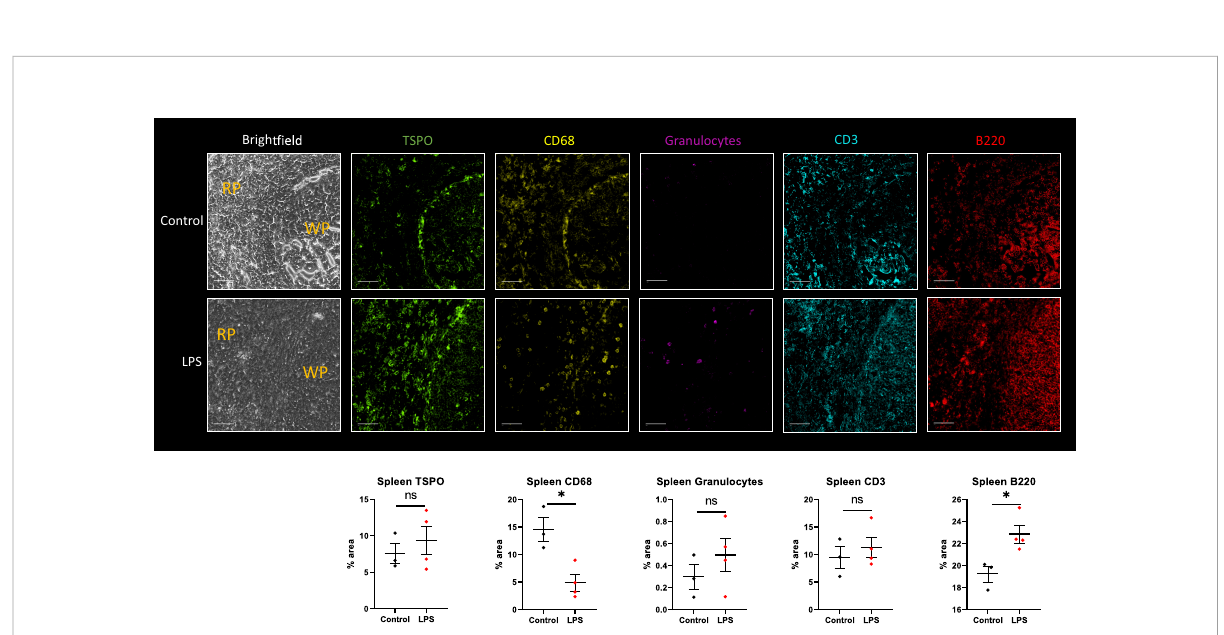
FIGURE 7 Immunohistochemistry in spleen tissue sections. Representative MF-IHC images of a single spleen section from control (top panels) and LPS- treated rat (bottom panels). The regions shown here include both the red pulp (RP) and white pulp (WP) areas as indicated in the bright fi eld images. Quanti fi cation of the various stains was obtained by measuring multiple ROIs in the red and white pulp spleen section using Image J. Percentage area values are shown under each panel for TSPO, CD68 (macrophages), MHCII (dendritic cells), Granulocytes (neutrophils), CD3 (T cells), and B220 (B-cells). No signi fi cant statistical difference in TSPO expression between groups is seen with two out of four animals showing increased staining, as shown. This is seen despite signi fi cant decreased immunoreactivity for CD68-monocytes/macrophages (p=0.0003), likely due to increased lymphocytic expression in the LPS group (n=4) compared to controls (n=3). Statistical analysis was performed using unpaired t-test. Mean with SEM are shown. p-values <0.05 are considered statistically signi fi cant. *p<0.05, not signi fi cant